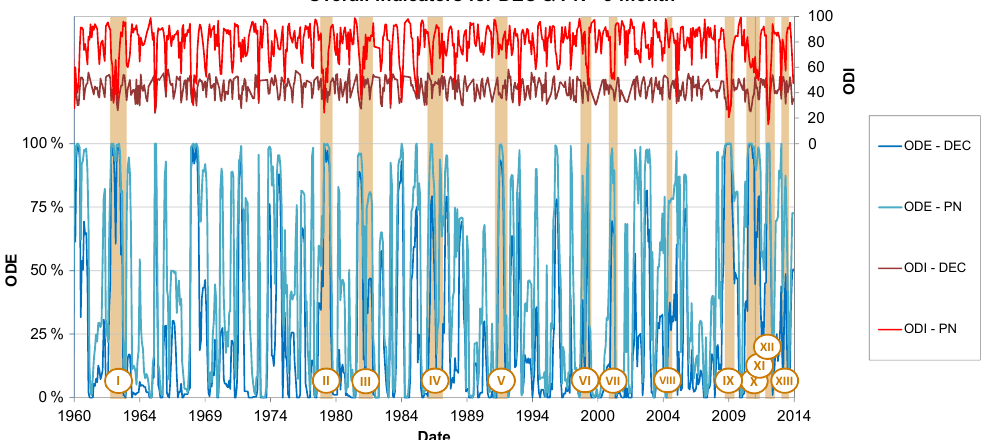
Figure A4. ODE and ODI values using the 3-month timescales of DEC and PN indices, compared with the 13 detected historical droughts (in